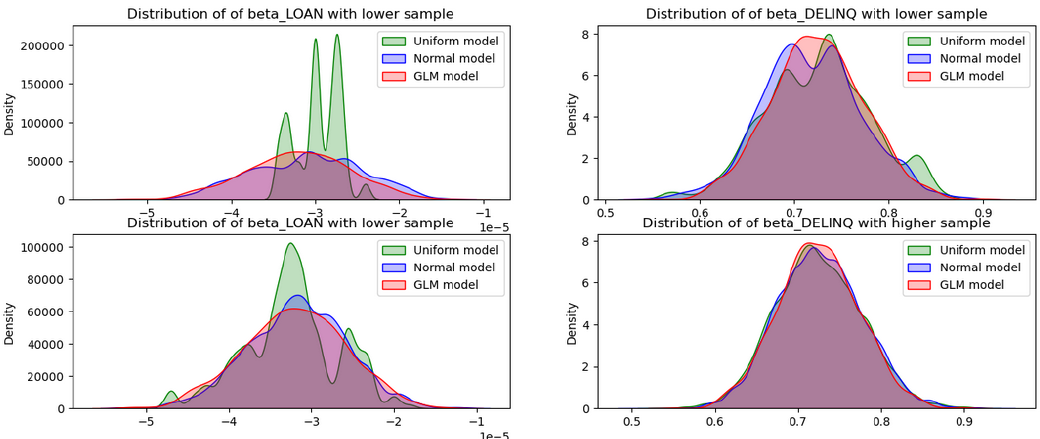
Figure 12. Distributions of variables–Comparisons between the lower (2500 samples) and higher (9000 samples) samples.